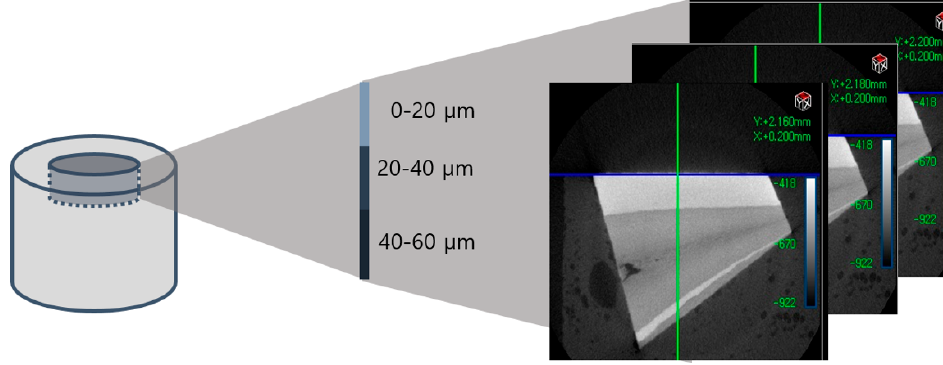
Figure 2. Each specimen’s mineral density was evaluated at three depths (0–20 μ m, 20–40 μ m, 40–60 μ m).